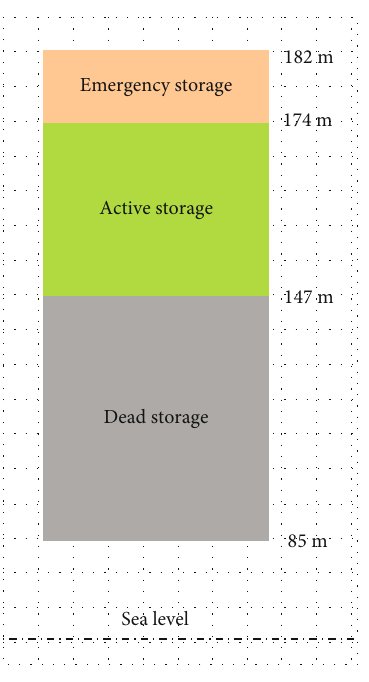
Figure 2: The total capacity of the Lake Nasser